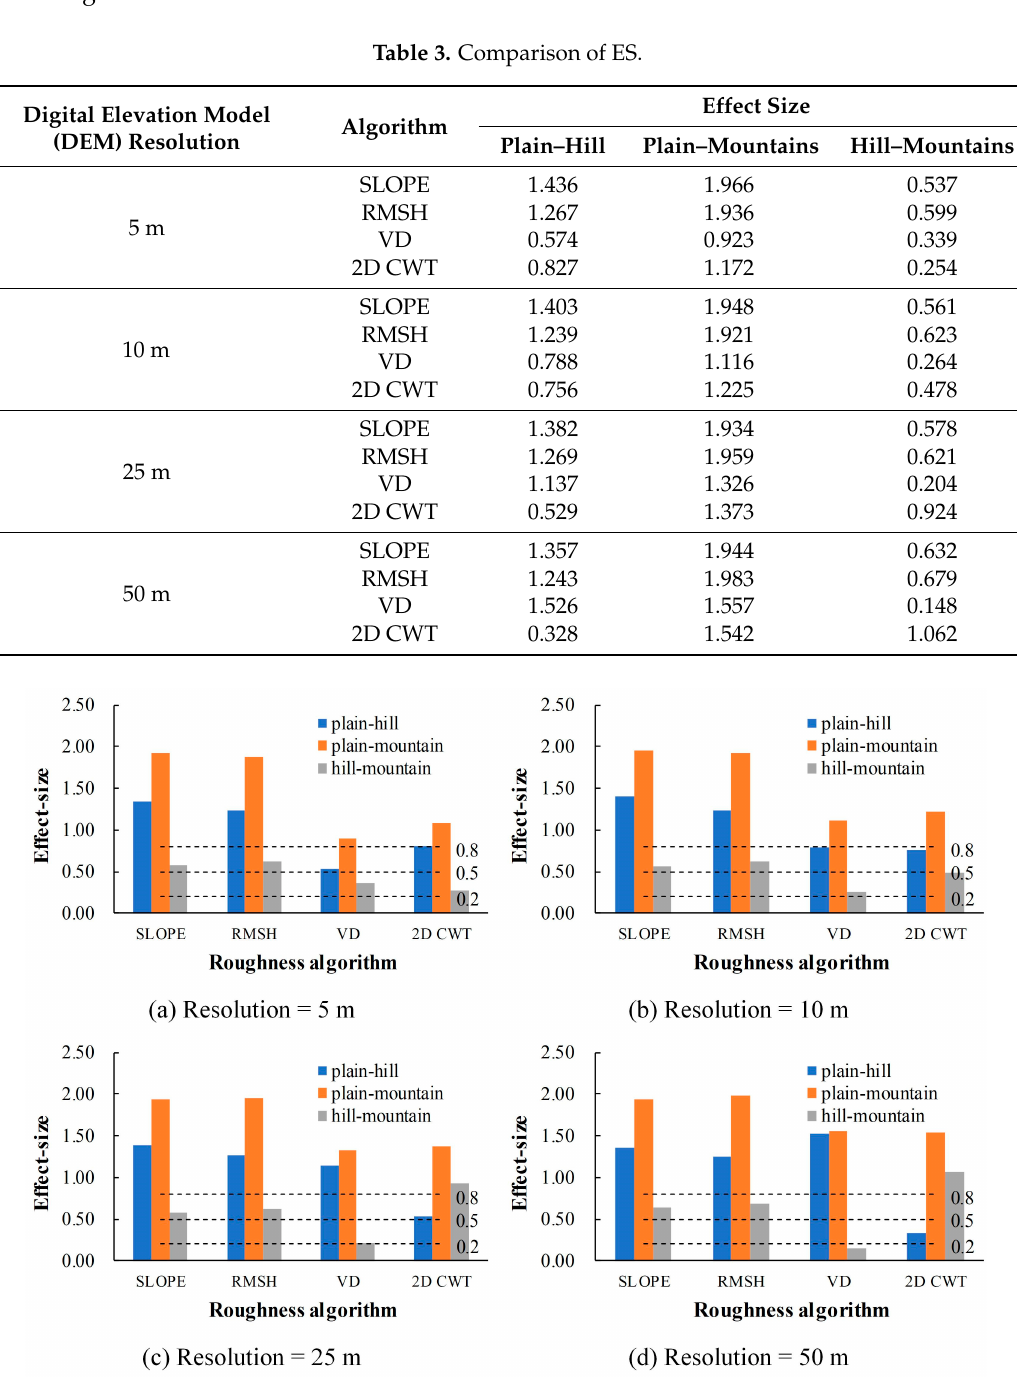
Figure 4. ES for different roughness values in different regions with different resolutions.